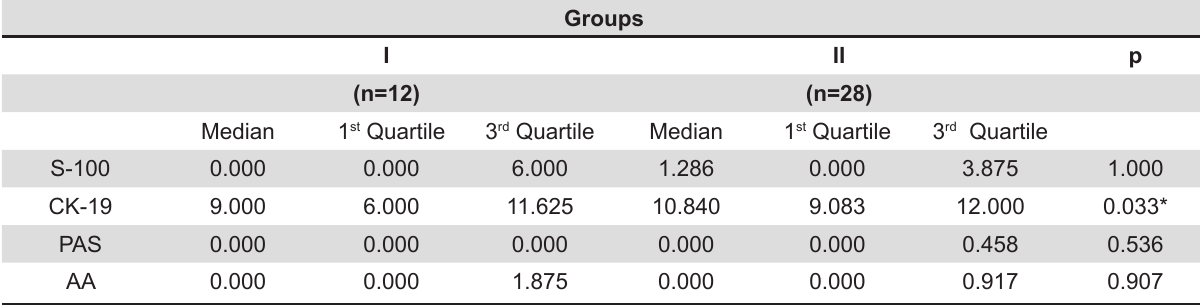
Table 1- Comparison between groups regarding histochemical and immunohistochemical staining